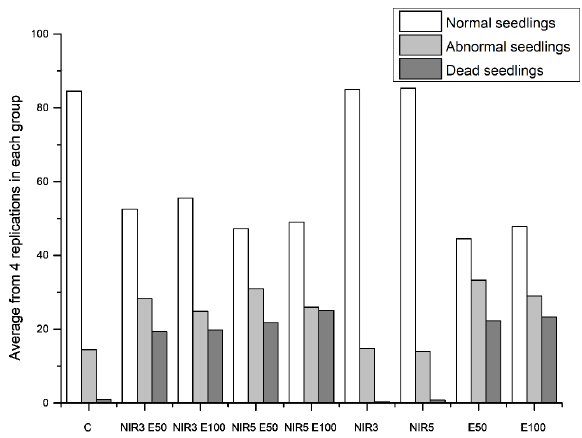
Figure 3: Number of normal, abnormal and dead seedlings in the tested